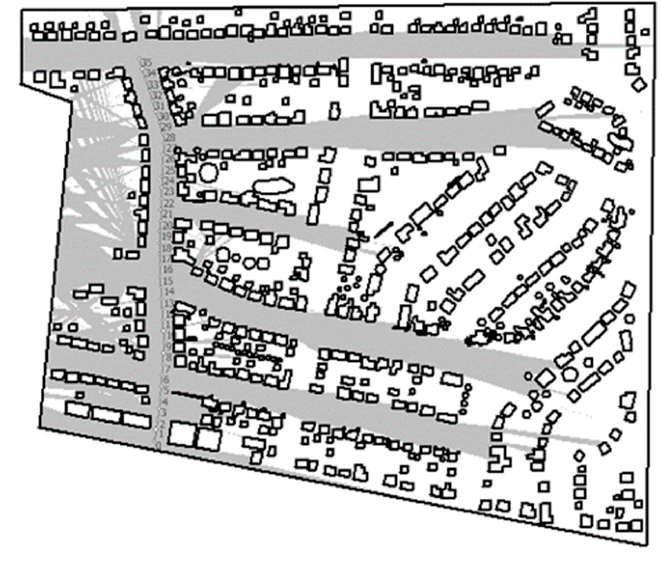
Figure 2. A sample path isovist output in the first neighborhood. The shaded areas represent the total visibility or amount of visual information available when one takes that route.